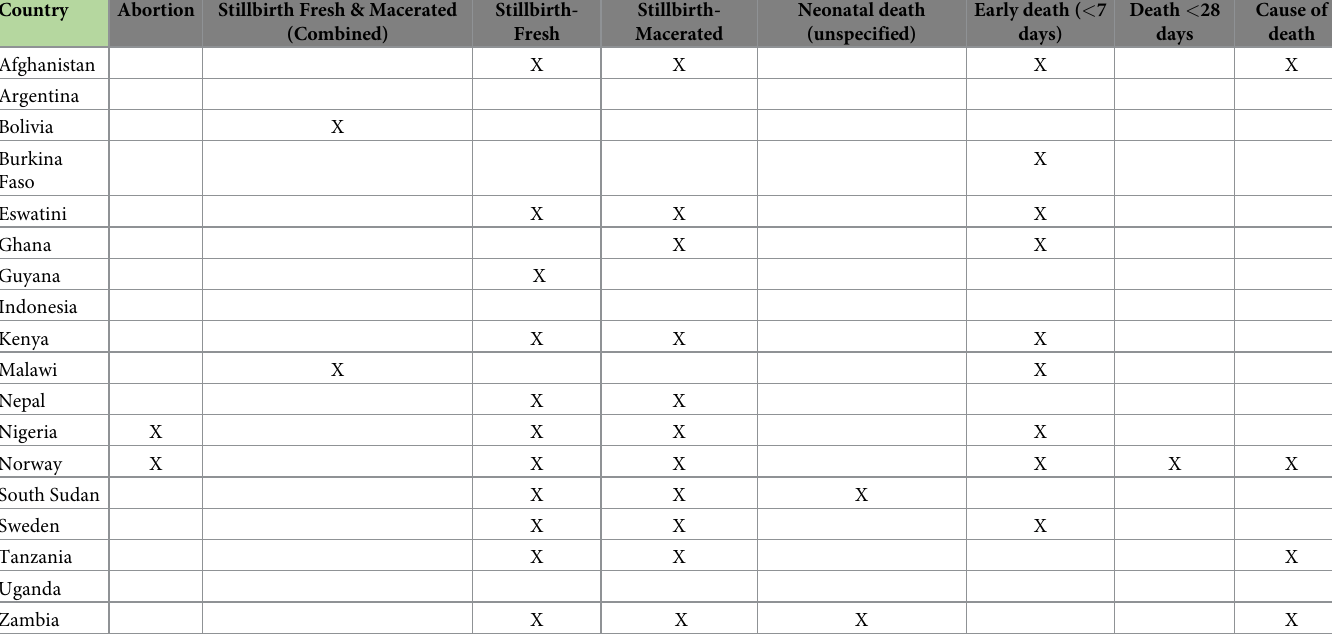
Table 7. Abortion, fetal and early death of the